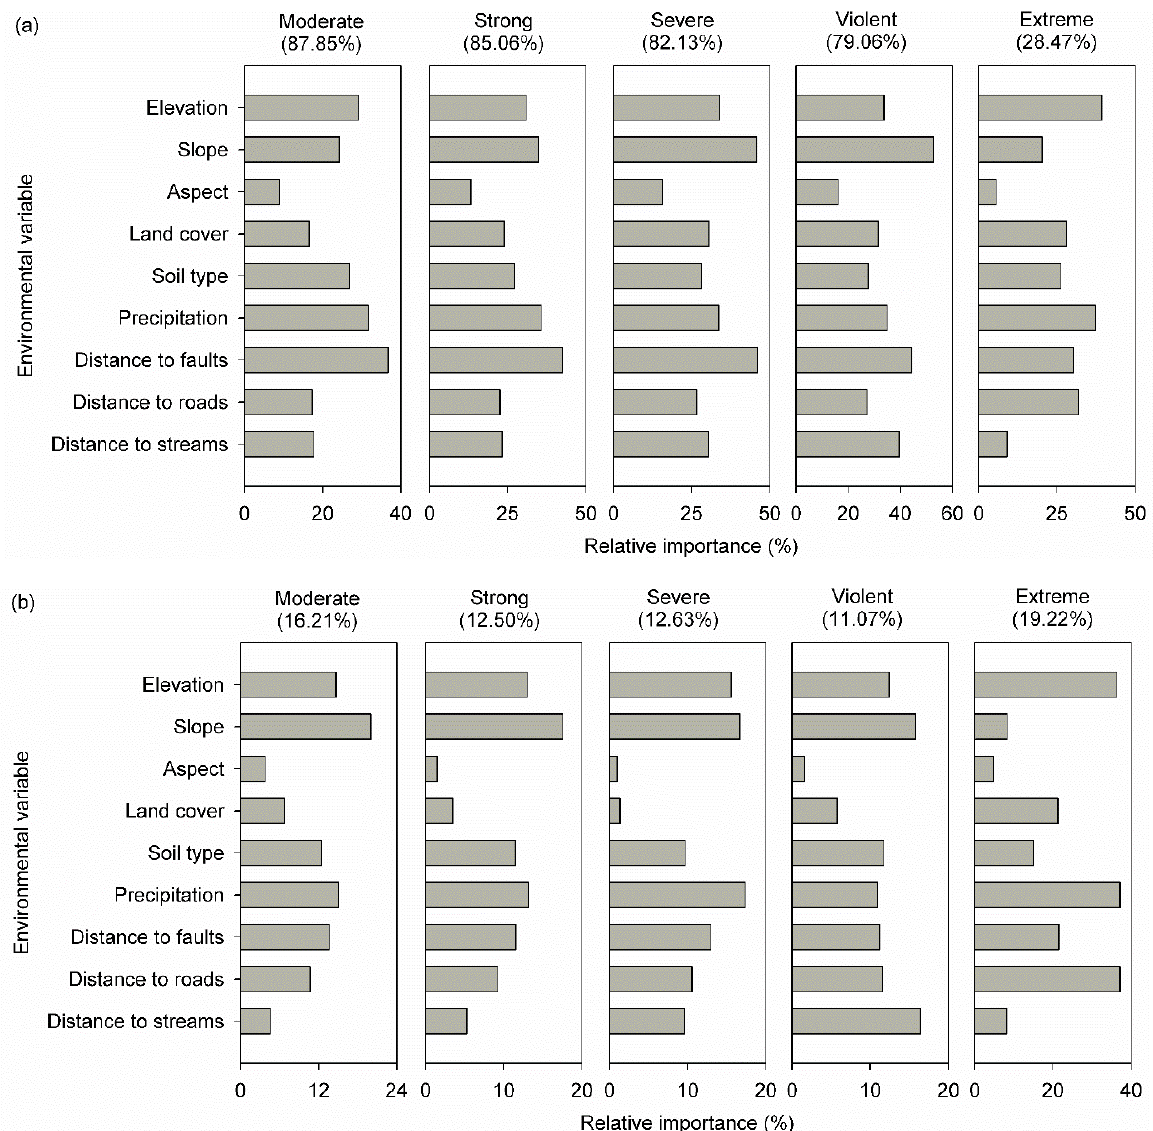
Figure 6. Relative importance of environmental variables for landslide metrics: ( a ) landslide susceptibility index and ( b ) volume of landslide under five earthquake scenarios. The value in bracket refers to the explanatory power of the random forest analysis.